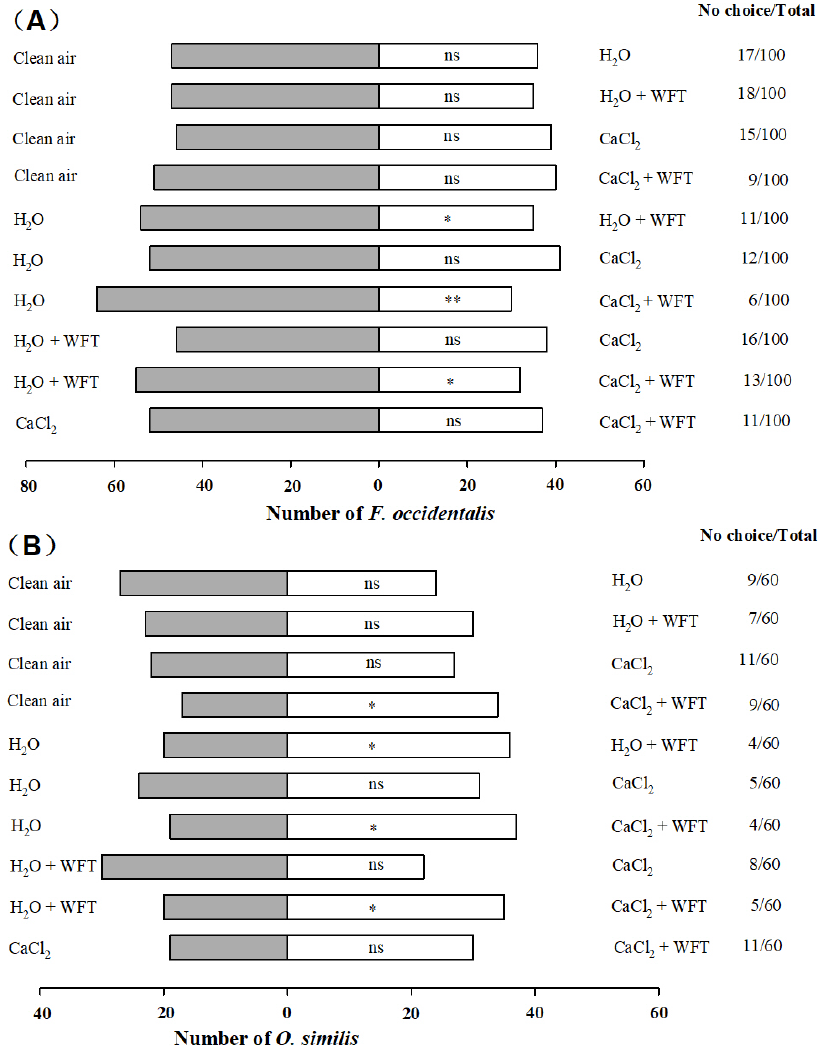
Figure 1. Olfactory responses of F. occidentalis ( A ) and O. similis ( B ) to volatiles from five test sources. Asterisks indicate significant differences based on χ 2 test (** p < 0.01, * p < 0.05). “ns” represents no significant difference ( p > 0.05).